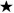
DHA stimulated autophagosomes (APs) formation and affected autophagic flux morphology. (Aa,Ba,Ca,Da,Ea,Fa,Ga) High magnification images of APs (arrows in Aa,Ba,Ca,Da,Ea,Fa,Ga) and lysosomes (*Aa,Ba,Ca,Da,Ea,Fa,Ga) or lipid droplets ( in Aa,Ba,Ca,Da,Ea,Fa,Ga) of N2a-APP cells in the seven groups were detected by TEM after treatment with DMSO (Aa), DHA (1 μM, 24 h) (Ba), bafilomycin A1(50 nM, 25 h) (Ca), bafilomycin A1 (50 nM, 25 h) and DHA (1 μM, 24 h) (Da), CQ (25 μM, 25 h) (Ea), CQ (25 μM, 25 h) and DHA (1 μM, 24 h) (Fa), rapamycin (100 nM, 24 h) (Ga). (Ab,c,Bb,c,Cb,c,Db,c,Eb,c,Fb,c,Gb,c) APP-SH-SY5Y cells were transfected with a tandem mRFP-GFP-LC3 adenovirus for 24 h, followed by treatment with DHA (1 μM, 24 h) (Bb,c), bafilomycin A1 (1 nM, 25 h) (Cb,c), bafilomycin A1 (1 nM, 25 h) and DHA (1 μM, 24 h) (Db,c), CQ (10 μM, 25 h) (Eb,c), CQ (10 μM, 25 h) and DHA (1 μM, 24 h) (Fb,c) and rapamycin (100 nM, 24 h) (Gb,c). APs were visualized in each group as yellow puncta under a confocal microscope. Scale bar (Aa,Ba,Ca,Da,Ea,Fa,Ga): 1 μm and (Ab,c,Bb,c,Cb-c,Db,c,Eb,c,Fb,c,Gb,c): 5 μm. (H,I) Positive puncta were counted, and the ratio of puncta near the nucleus in each cell was calculated. Randomly selected fields were counted, and the data are presented as the means ± SEM and were analyzed by one-way ANOVA (Newman–Keuls test, *p < 0.05, **p < 0.01, and ***p < 0.001 compared to CON group).